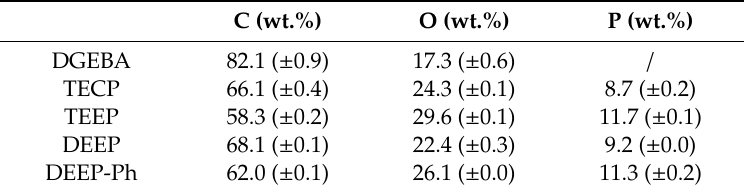
Table 4. Elemental composition of